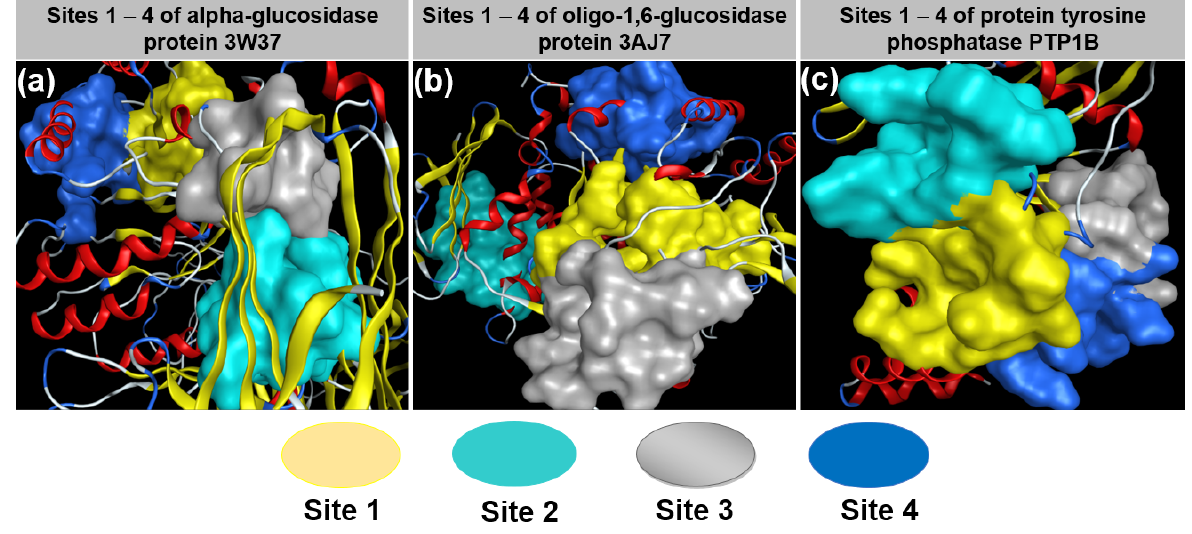
Figure 7. Quaternary structures of proteins ( a ) 3W37, ( b ) 3AJ7, and ( c ) PTP1B with their approachable sites by investigated compounds 1 and 2 : site 1 (yellow), site 2 (cyan), site 3 (grey), and site 4 (blue). Table 3. In-site amino acid residues of proteins 3W37, 3AJ7, and PTP1B.